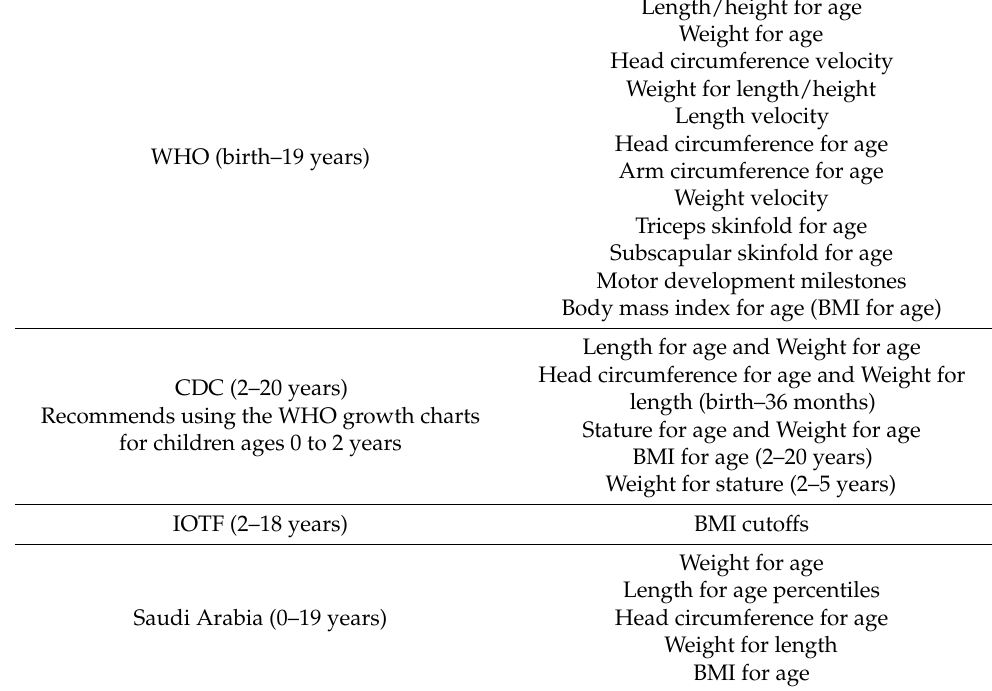
Table 1. International and national growth standards used in Saudi